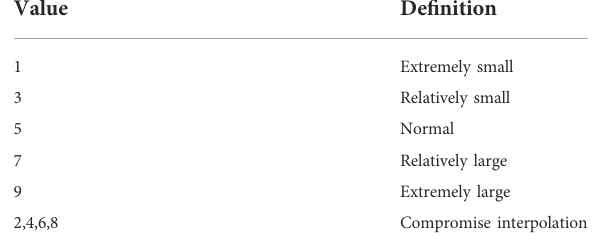
TABLE 8 Linguistic terms used in proposed